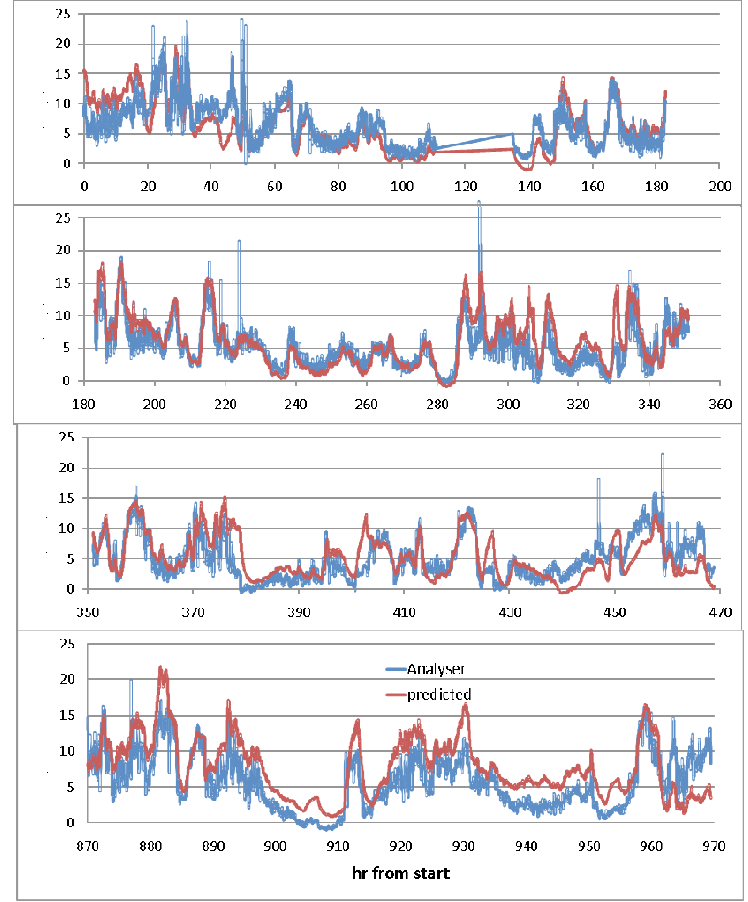
Figure 19. Graph comparing the responses of chemiluminescence and semiconductor sensors. Measurements were simultaneous and made every minute. X-axis indicates hours since experiment start and y-axis ppb concentration of NO permission from